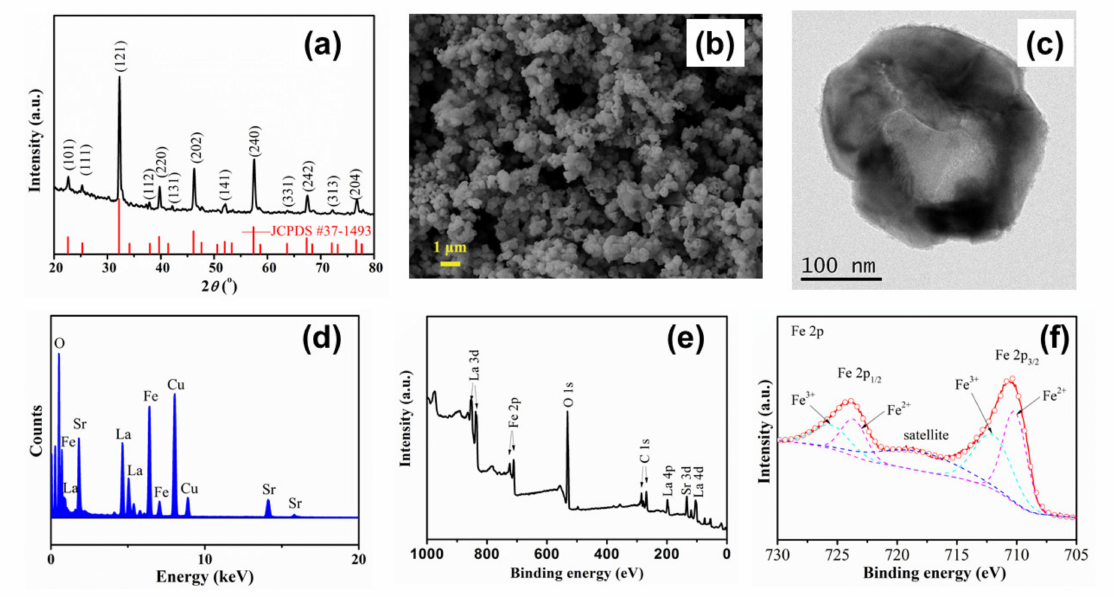
Figure 2. ( a ) XRD patterns of LSF powders; ( b ) SEM, ( c ) TEM images and ( d ) EDS spectrum of the particles; ( e ) overall XPS spectrum and ( f ) Fe 2p core level of